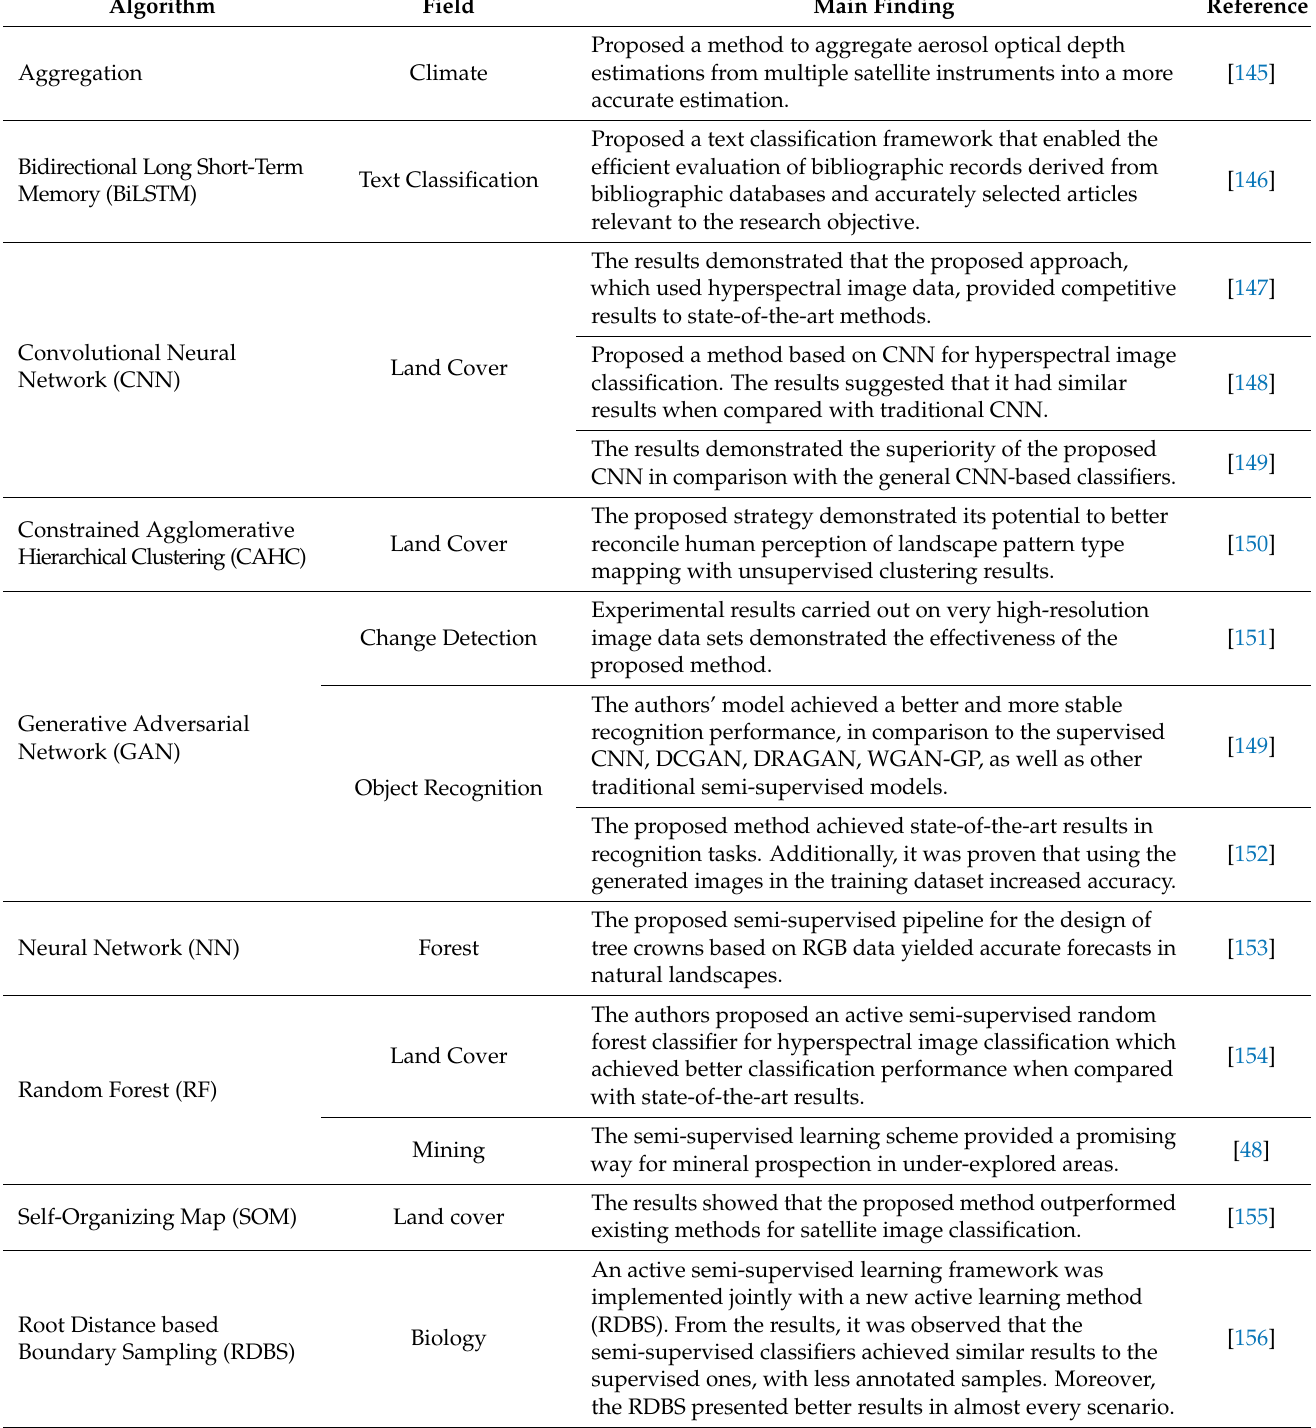
Table 5. Examples of application of semi-supervised learning techniques using EO